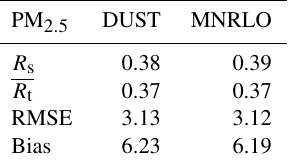
Table 4. Comparison of daily mean PM 2 . 5 surface concentrations (micrograms per cubic metre) between EMEP observations and the CHIMERE model. Results are presented for the spatial correlation R s between the mean observed and modelled values and the mean averaged values of temporal correlation, RMSE and